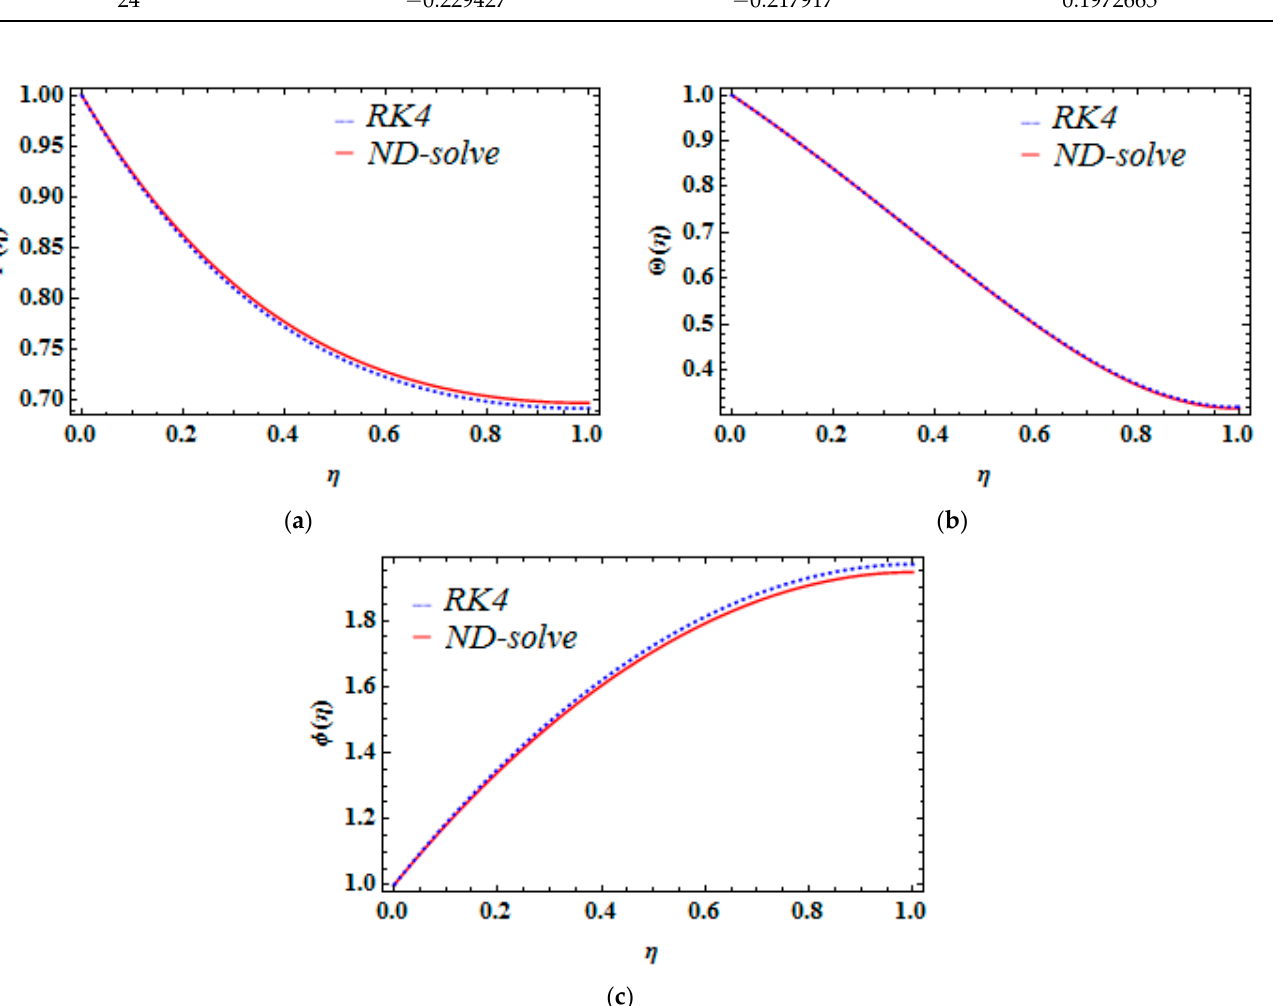
Figure 2. ( a ). A comparison of RK4 and NDSolve for ( a ) velocity field ( 𝑓 (cid:4593) ( 𝜂 ) ), ( b ) temperature field Θ ( 𝜂 ) , and ( c ) concentration profile 𝜙 ( 𝜂 ) . Θ ( η ) , and ( c ) concentration profile φ ( η )